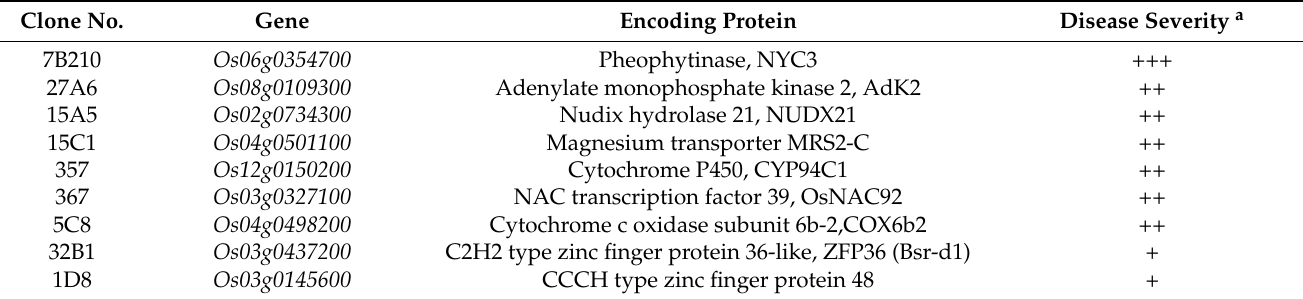
Table 1. Information on the candidate genes enhancing susceptibility. Clone No.